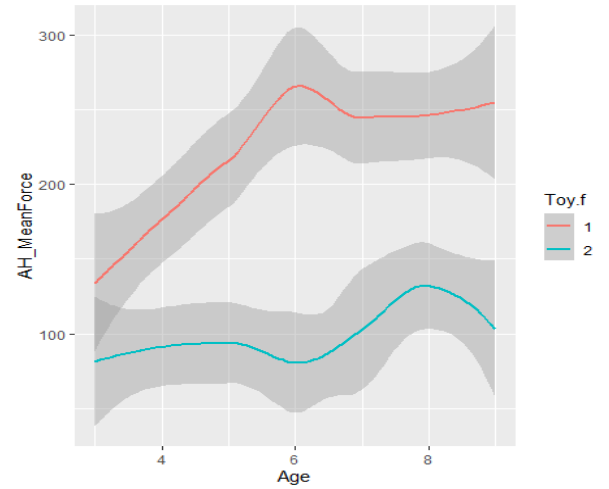
Figure 7. Relative affordance of the bar versus candy toys.